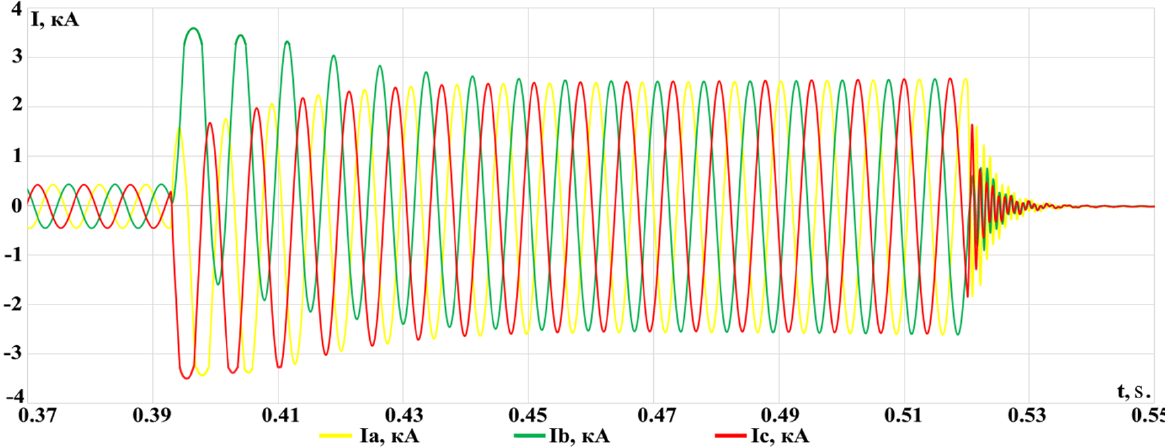
Figure 10. Line L 3 currents for a case of short ‐ circuit on the buses B 2 .